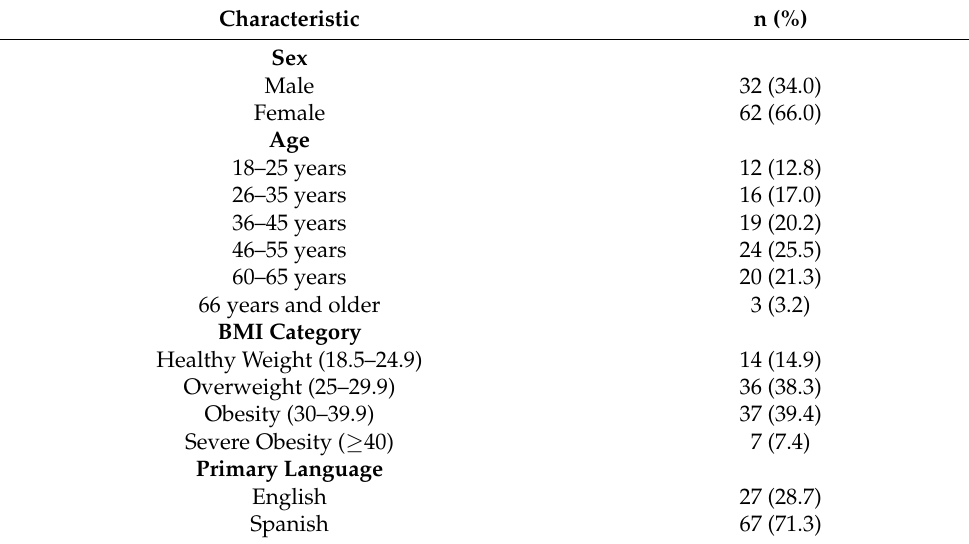
Table 2. Demographic characteristics of participants (n =